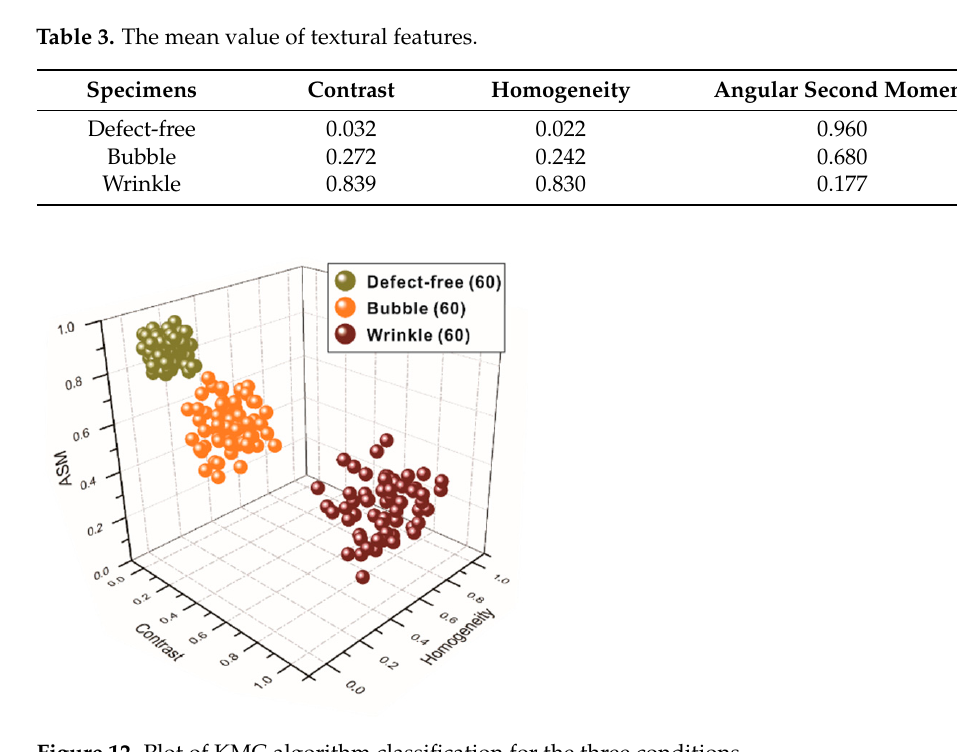
Figure 13. Plot of KMC algorithm classification for the three conditions with proportions of ( a ) 2:3:5, ( b ) 2:4:4, and ( c ) 2:5:3.